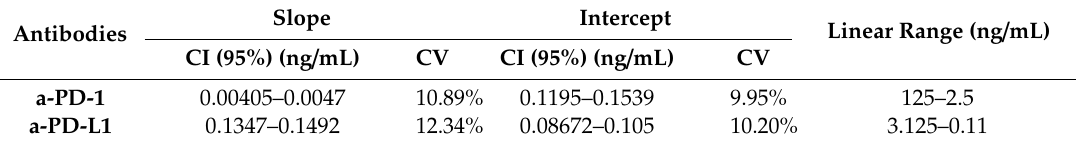
Table 2. Interval for slope and intercept for each standard curve, with the linearity range. Data were calculated using six di ff erent standard curves for each